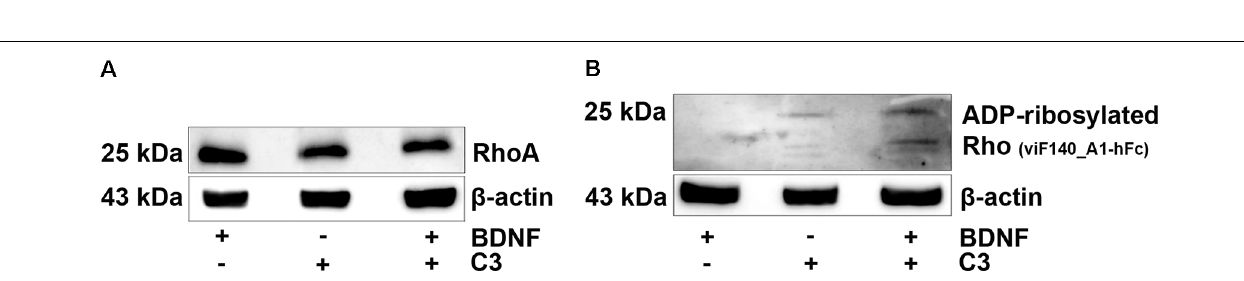
FIGURE 2 | Western blotting experiments. Western blot analysis of cell lysates from SGN treated with brain-derived neurotrophic factor (BDNF), C3, and C3 plus BDNF. Cell lysates were prepared from SGN after 48 h cultivation. ß-actin served as the loading control. (A) RhoA could be detected in all samples, independent from the treatment. (B) After the treatment with C3 and C3 plus BDNF, ADP-ribosylated RhoA was detected in the SGN cell lysates. Thus, 50 nM of C3 was sufficient to ADP-ribosylate RhoA in intact SGN and confirmed uptake of